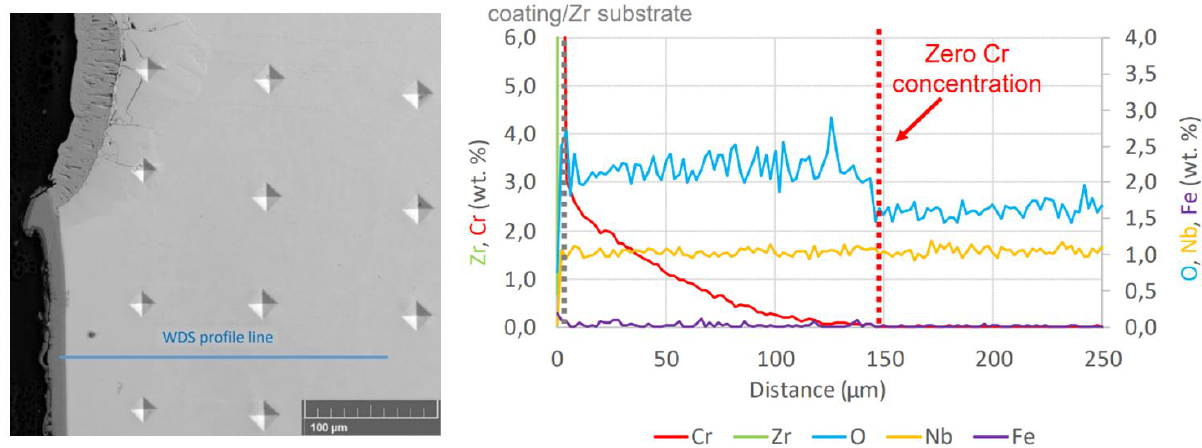
Figure 9. WDS composition profile perpendicular to the coating, 4,5 min HT oxidation.